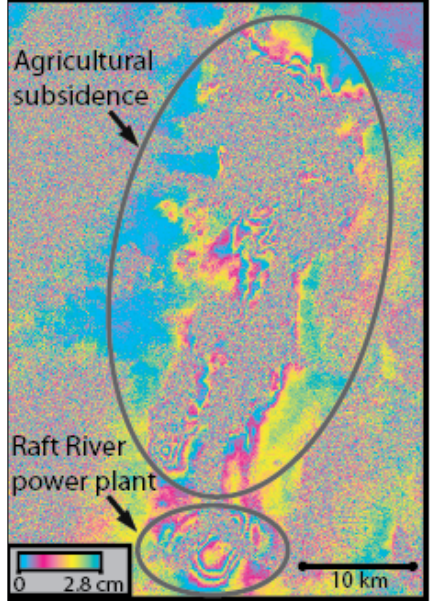
Figure 9. Wrapped interferogram from 8 December 2006 to 3 September 2010 showing subsidence in the Raft River Valley, ID, related to groundwater pumping for agricultural use near Burley, ID [55], and both uplift and subsidence at the Raft River geothermal power plant